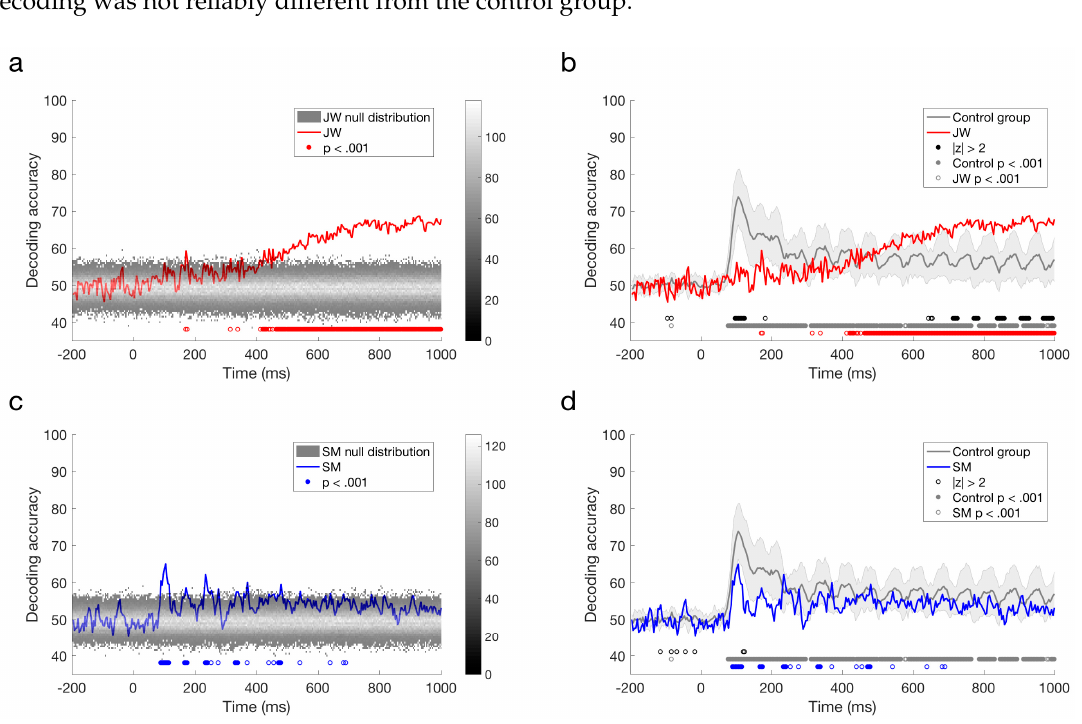
Figure 5. Time course classification results for visual agnosia patients. ( a ) JW’s decoding performance compared to shuffled label permutations. ( b ) JW’s decoding performance compared to the control group. ( c ) SM’s decoding performance compared to shuffled label permutations. ( d ) SM’s